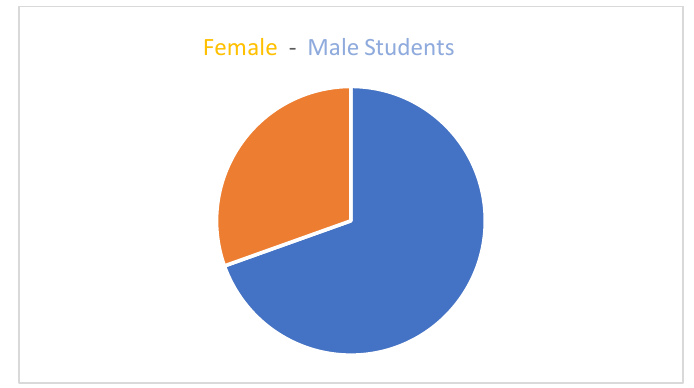
Fig. 1: Gender repartition of the distance learning